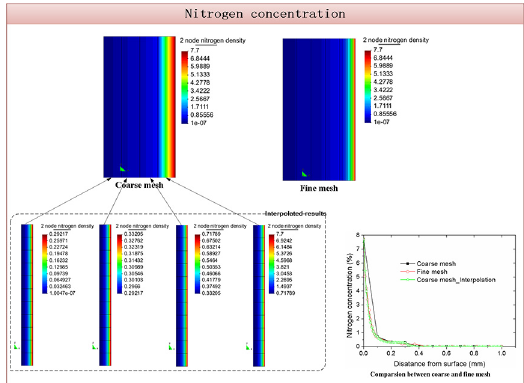
Figure 9. Comparisons of nitrogen concentrations for different meshes